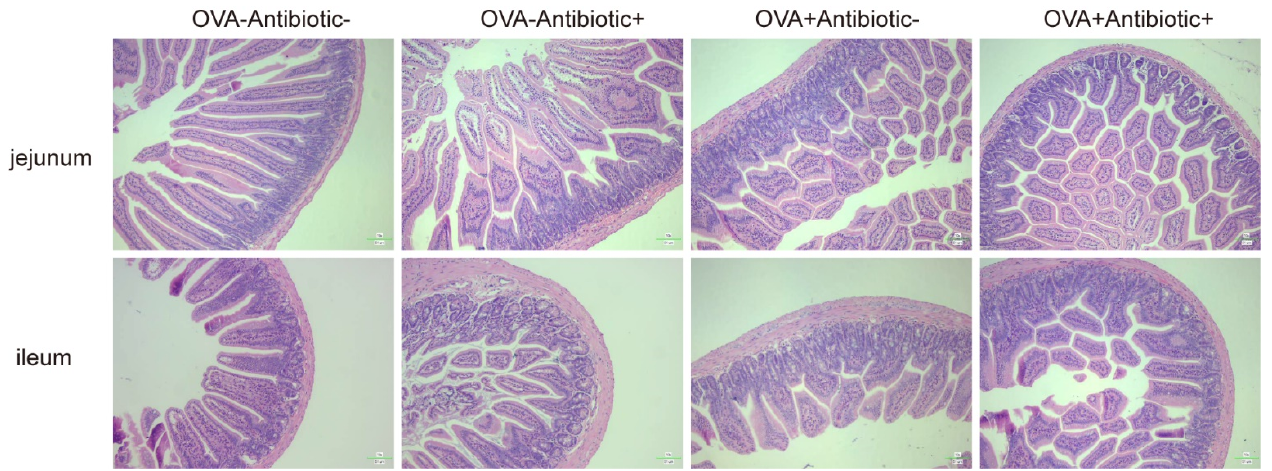
Figure 7. HE staining of sections of jejunum and ileum in the food allergy–gut microbiota dysbiosis model.